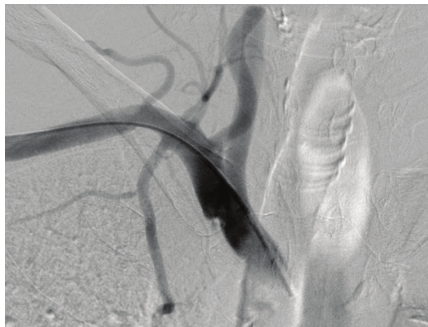
Figure 4: Catheter angiogram following deployment of Angio-Seal